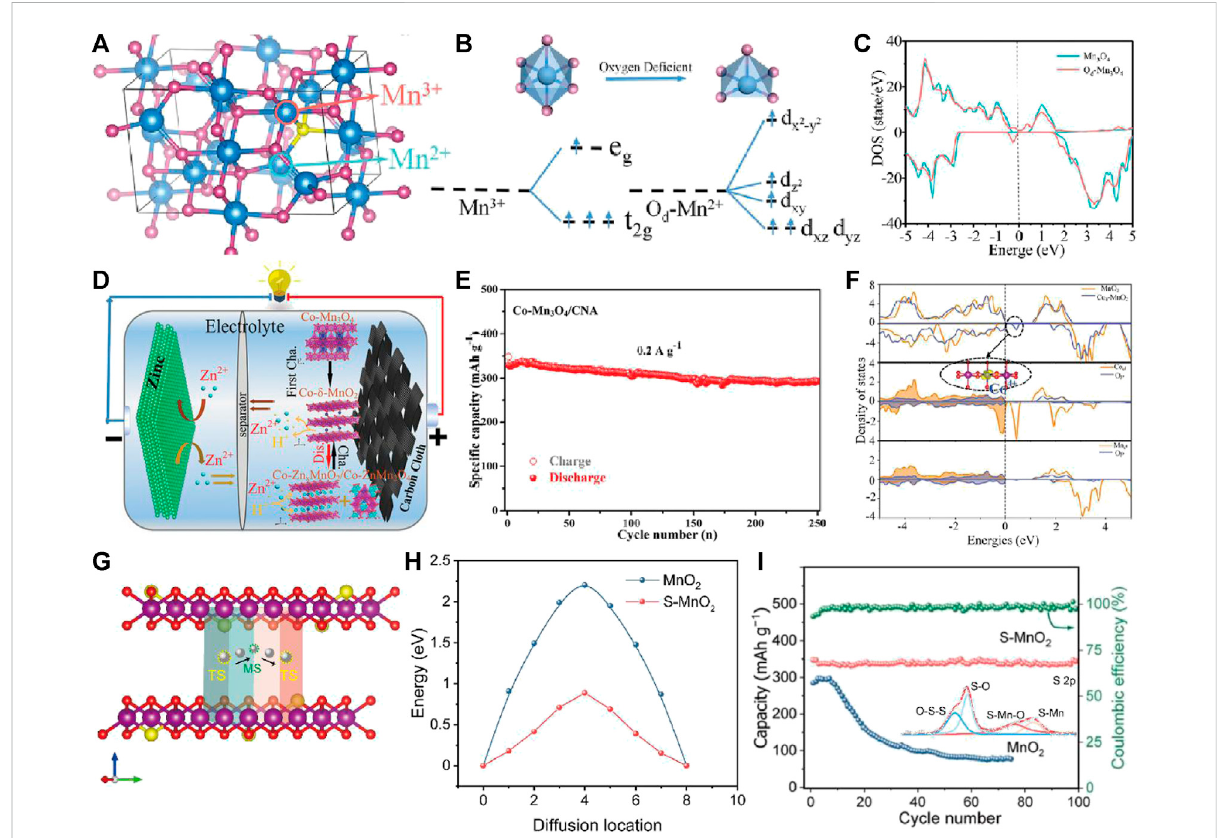
FIGURE 1 (B) The Mn-O octahedral and pyramidal crystal fi elds and the d-orbital splitting con fi gurations. (C) The TDOS of (A) Supercell model of Mn 3 O 4 . the Mn 3 O 4 and Od-Mn 3 O 4 bulk phase. (D) Schematic illustration of Zn//Co-Mn 3 O 4 /CNA battery. (E) Cycling performance of the Co-Mn 3 O 4 /CNA at 0.2 A g − 1 . (F) DOS of MnO 2 and Co 4+ - δ -MnO 2 . (G) The side view of schematic illustration of Zn migration in S-MnO 2 . (H) The Zn ion diffusion